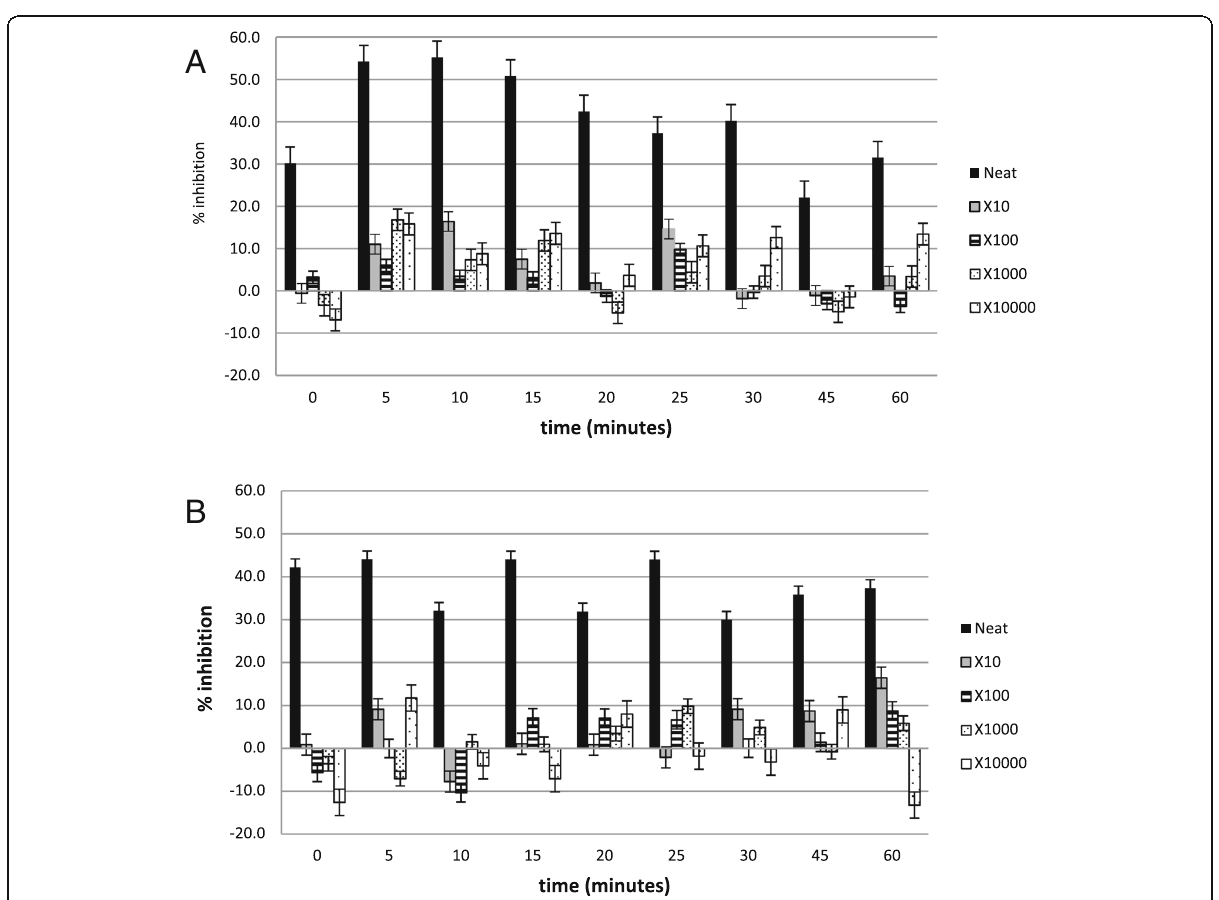
Fig. 2 The % inhibition of platelets after incubation with the neat HM1 and diluted standards, and activation with ( a ) fMLP and ( b )